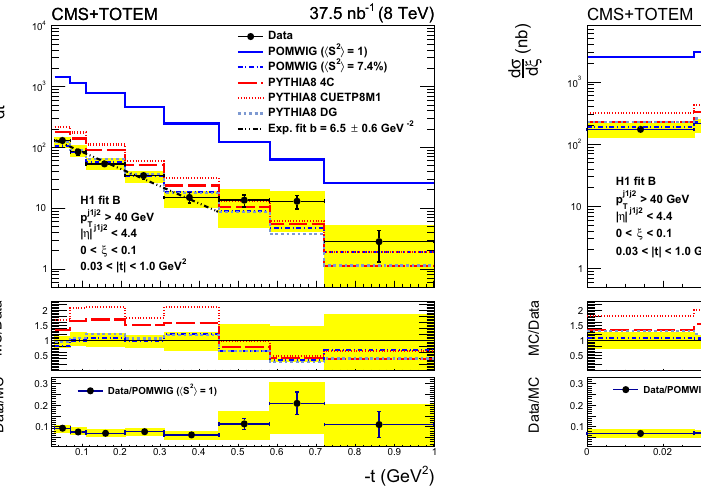
the yellow band indicates the total systematic uncertainty. The average of the results for events in which the proton is detected on either side of the interaction point is shown. The ratio between the data and the pomwig prediction, when no correction for the rapidity gap survival probability is applied, is shown in the